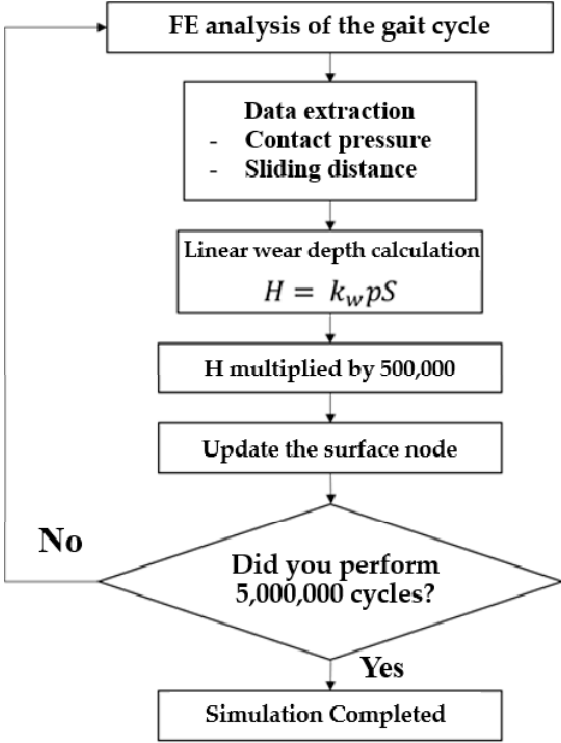
Figure 8. The flow chart of the process of deriving the results of the wear depth.